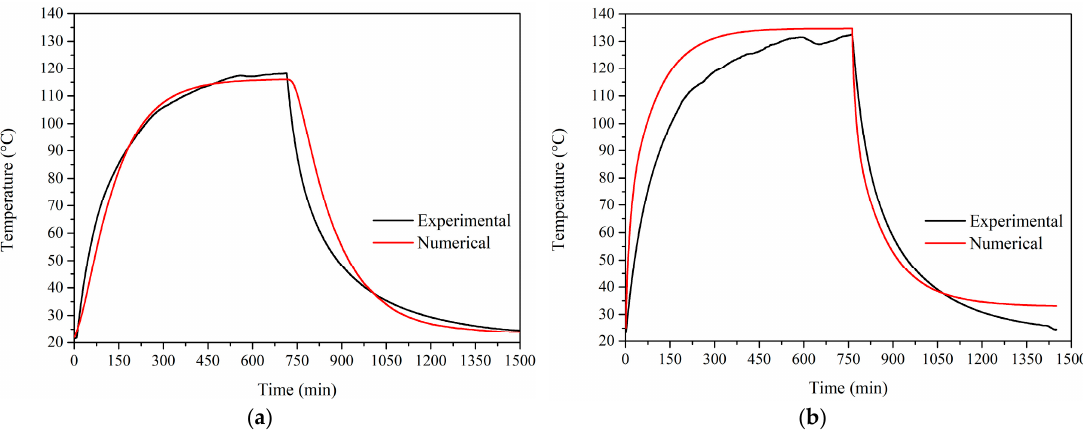
Figure 8. Comparison between numerical and experimental temperatures for ( a ) linear load and ( b ) dynamic load.